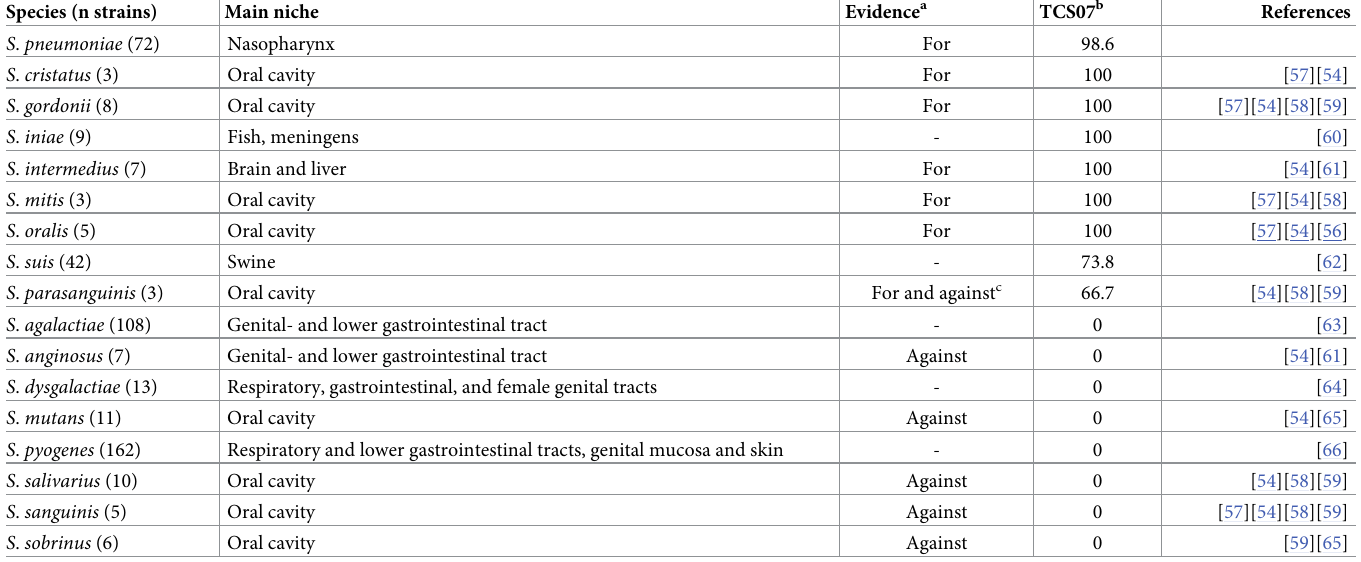
Table 2. The presence of TCS07 in strains from different streptococci species correlates with known ability to catabolize glycans. Species (n strains) Main